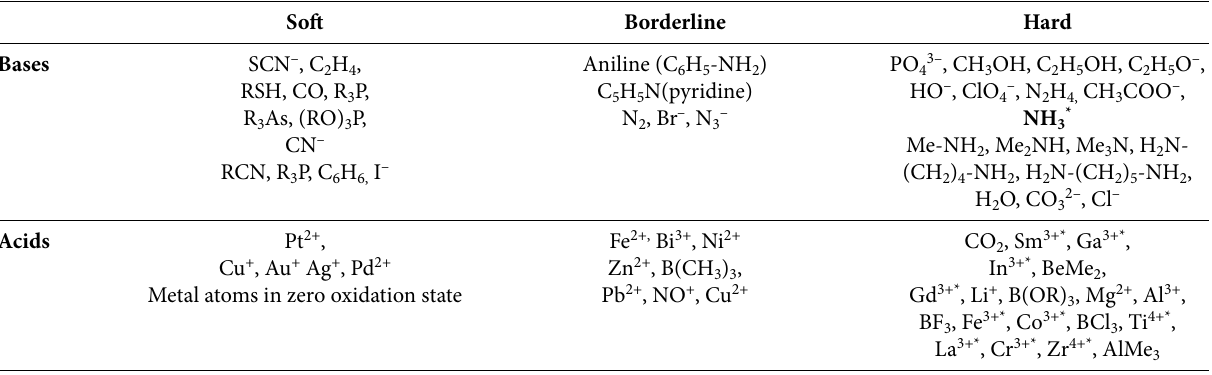
Table 1. Examples of hard, soft and borderline acids and bases Soft Borderline Hard Bases SCN – , C 2 H 4